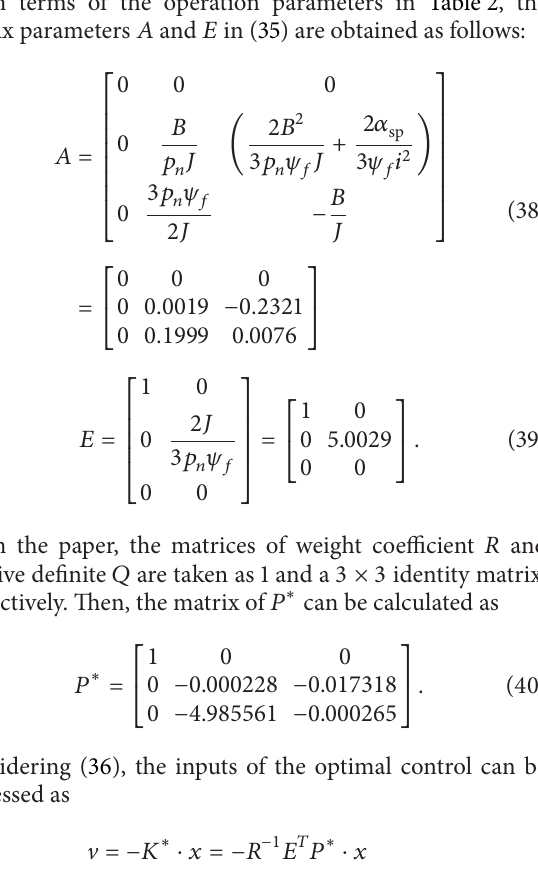
For the linearized system (35), the theory of linear